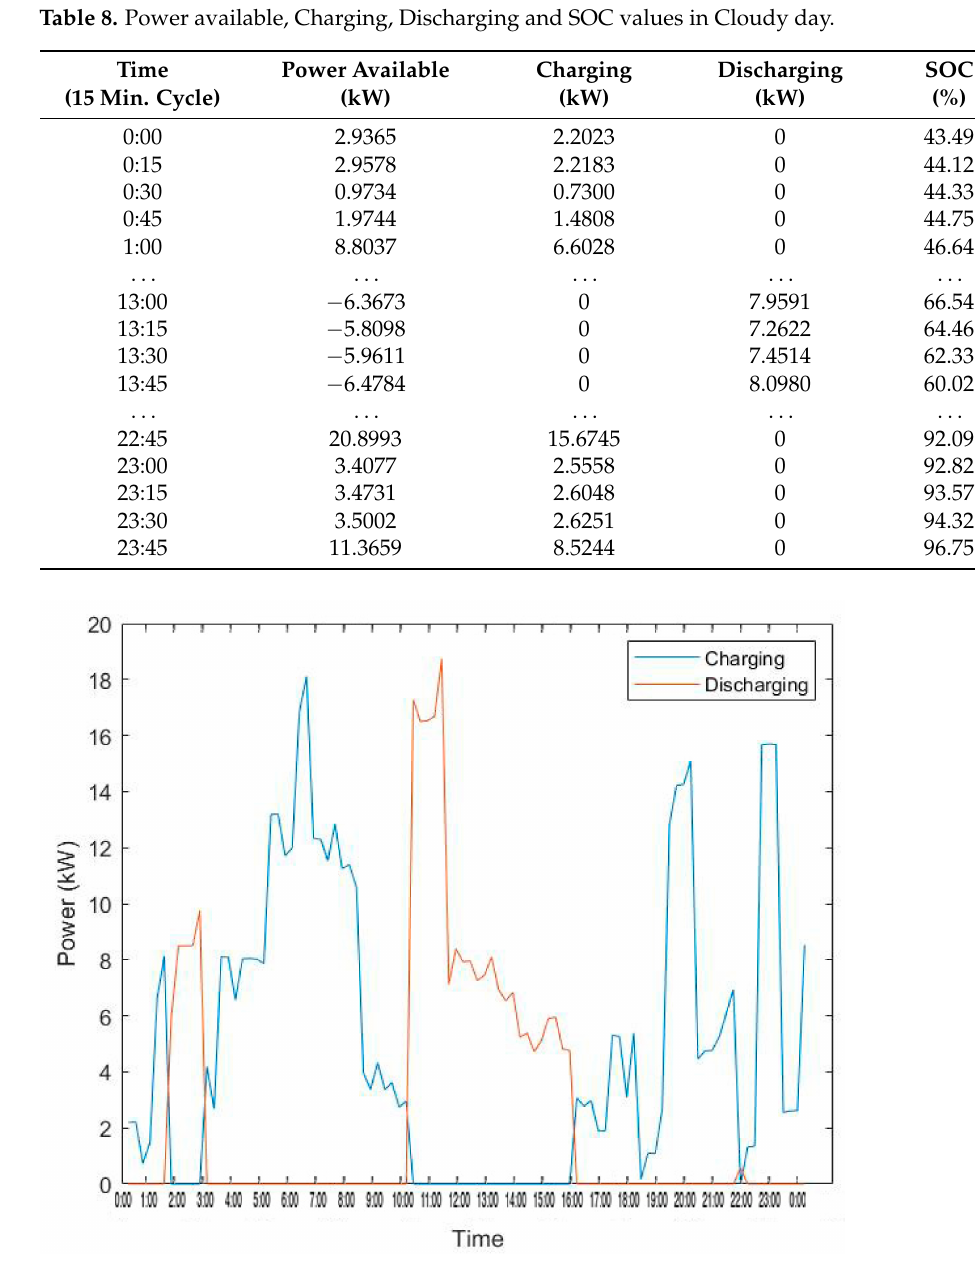
Figure 16. Charging and Discharging of Street Battery in Cloudy